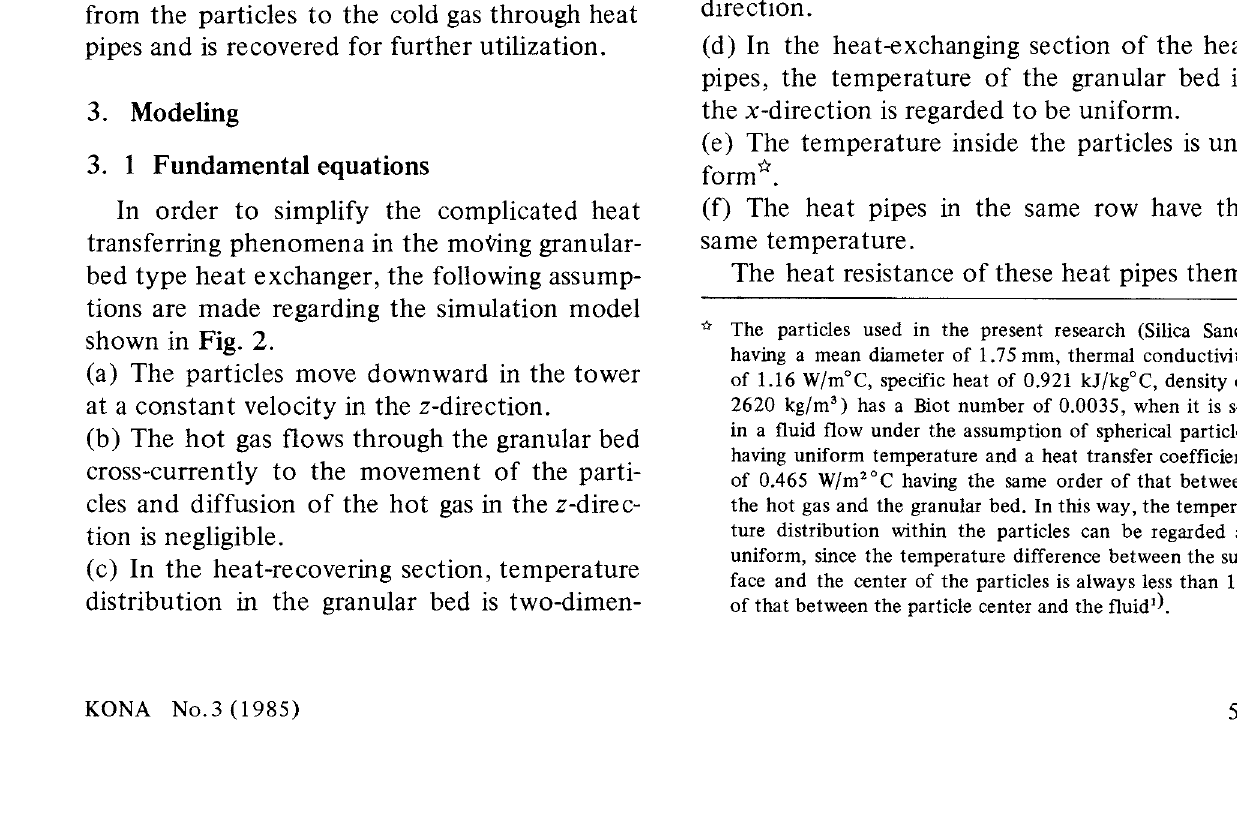
Fig. 2 A Model for simulation of the heat